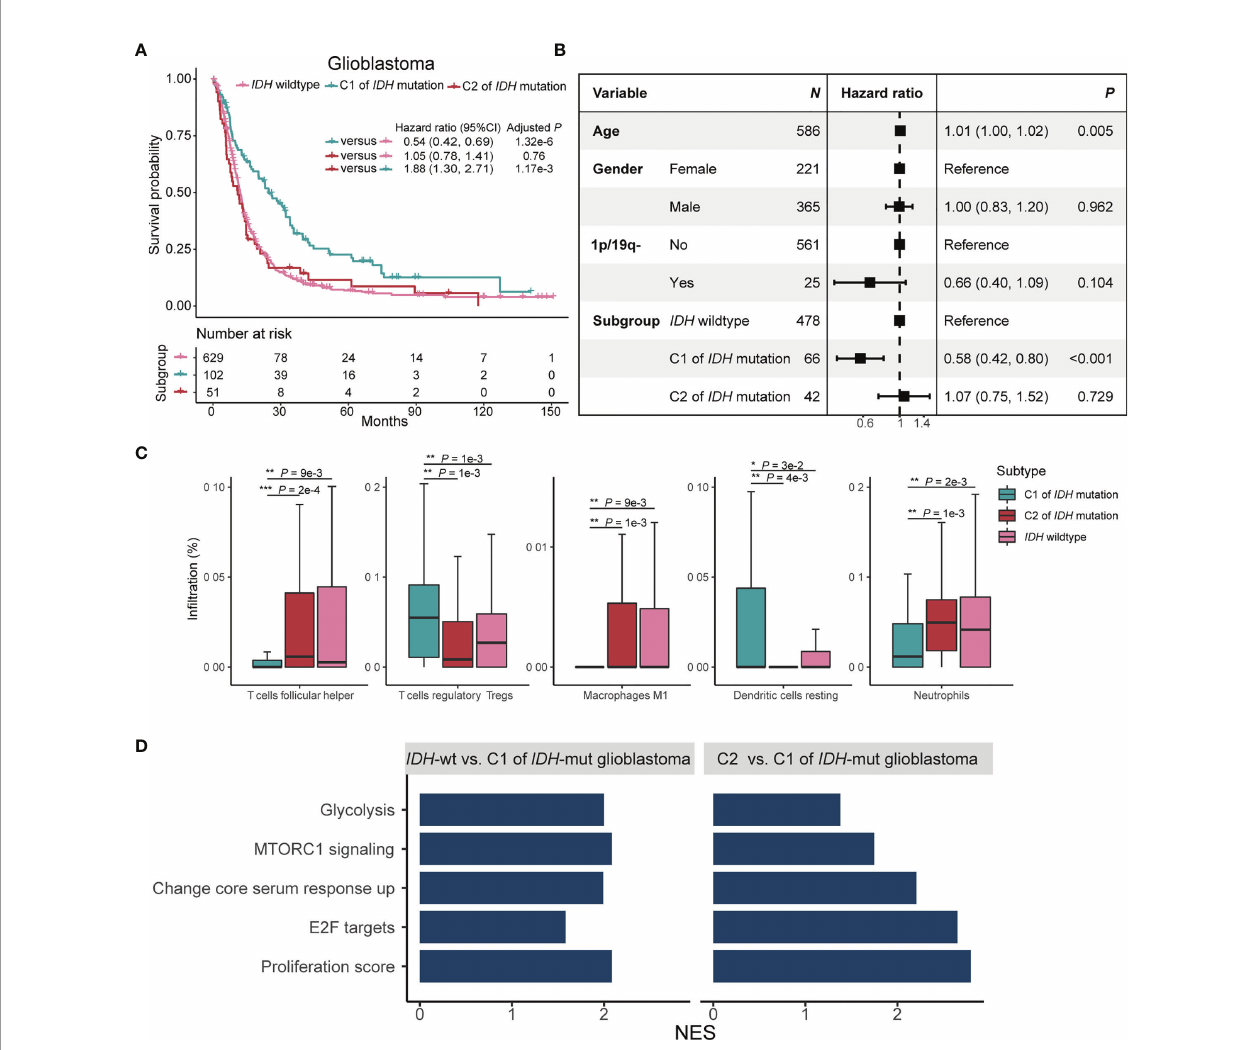
FIGURE 4 | Prognostic signi fi cance and immune signatures of IDH mutation plus C1/2 subtype in glioblastoma patients. (A) Kaplan-Meier survival analysis of glioblastoma in patients without IDH mutation, C1 subtype with IDH mutation, and C2 subtype with IDH mutation. (B) Multivariate Cox regression analysis of C1/2 subtypes by ruling out confounding impacts such as age, gender, and co-deletion of 1p and 19q. 1p/19q-, co-deletion of 1p and 19q; CI, con fi dence interval. (C) Immune cell in fi ltration rates of the trichotomy of glioblastoma. (D) Biological pathway enrichment scores of glioblastoma without IDH mutation and C2 subtype of glioblastoma with IDH mutation relative to C1 subtype of glioblastoma with IDH mutation. NES, normalized enrichment score. NES, number of enrichment